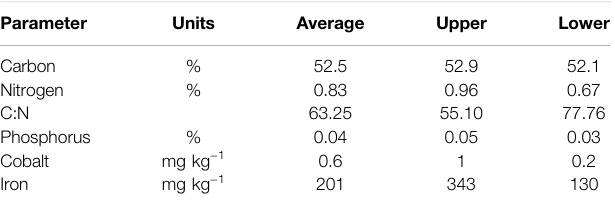
TABLE 3 | Forest litter macronutrient and mineral content from thee sampling events during lateral transport monitoring at Little Nerang Dam. Parameter